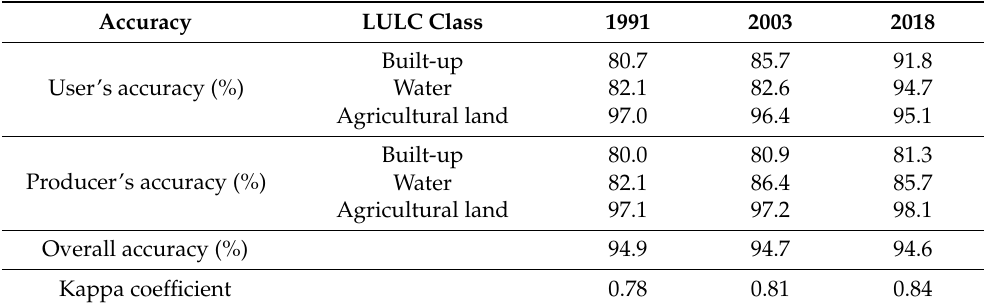
Table 3. Classification accuracy assessment of LULC types.